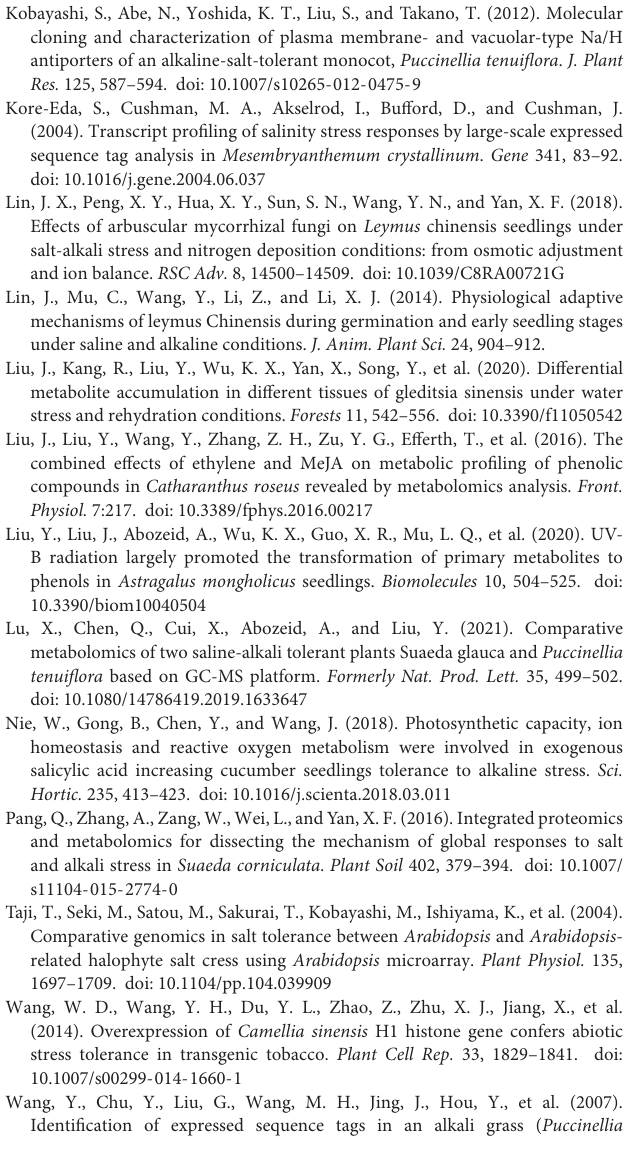
Supplementary Figure 1 | The OPLS-DA score plot between S. salsa community and P. tenuiflora community. (A) The OPLS-DA score plot of element metabolisms, (B) The OPLS-DA score plot of primary metabolisms, (C) The OPLS-DA score plot of phenolic compounds, Green circle: S. salsa community, blue circle: P. tenuiflora